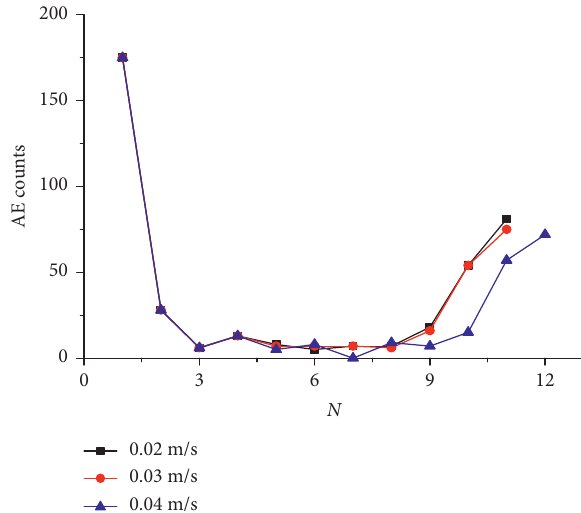
Figure 10: Cumulative AE counts curves per cycle under different loading-unloading